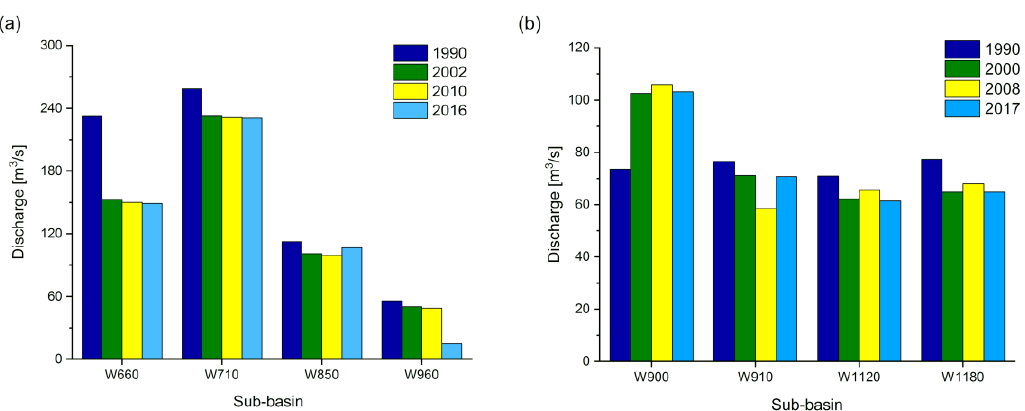
Figure 12. Calculated flood peak discharge (m 3 /s) of selected sub-basins under different land use land cover scenarios for the Yanhe ( a ) and Guangyuan ( b ) watersheds.